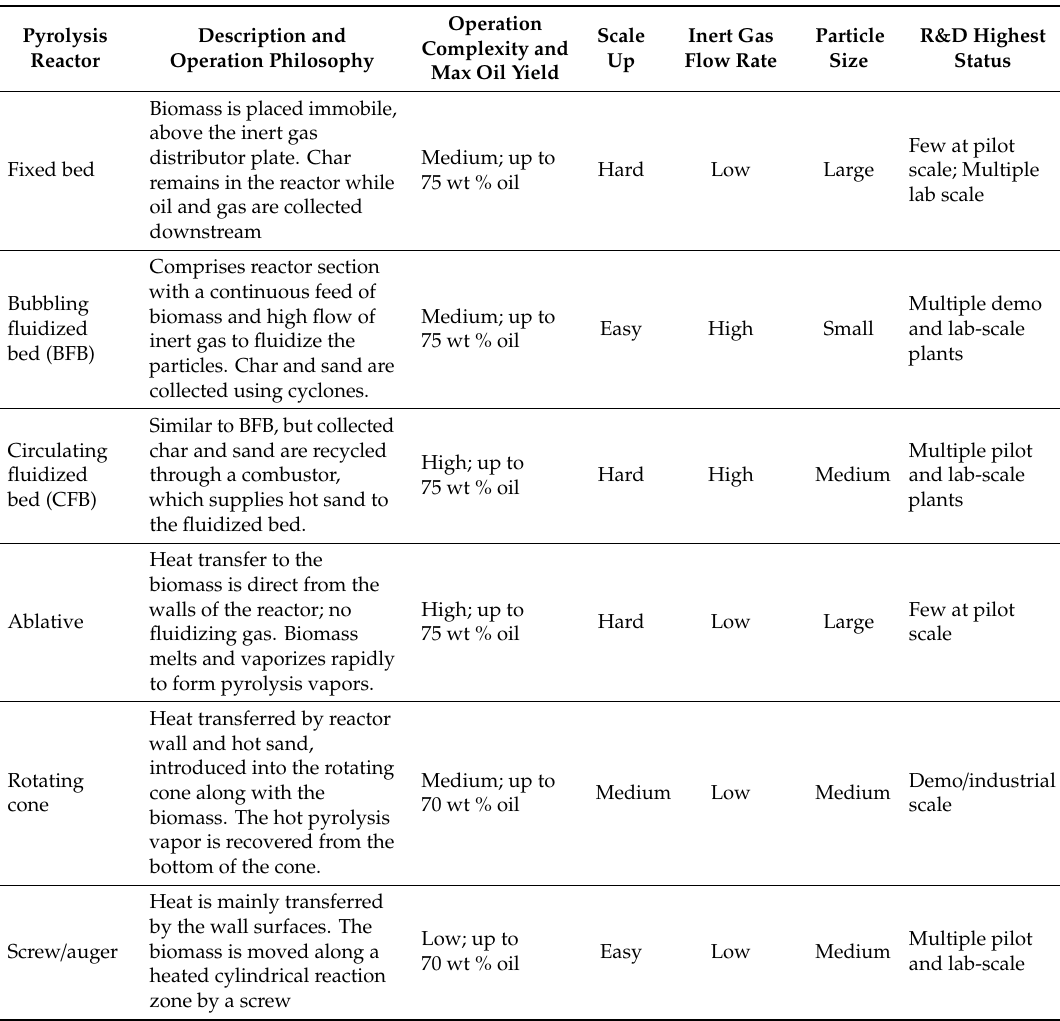
Table 1. Trending pyrolysis technologies. Adapted from